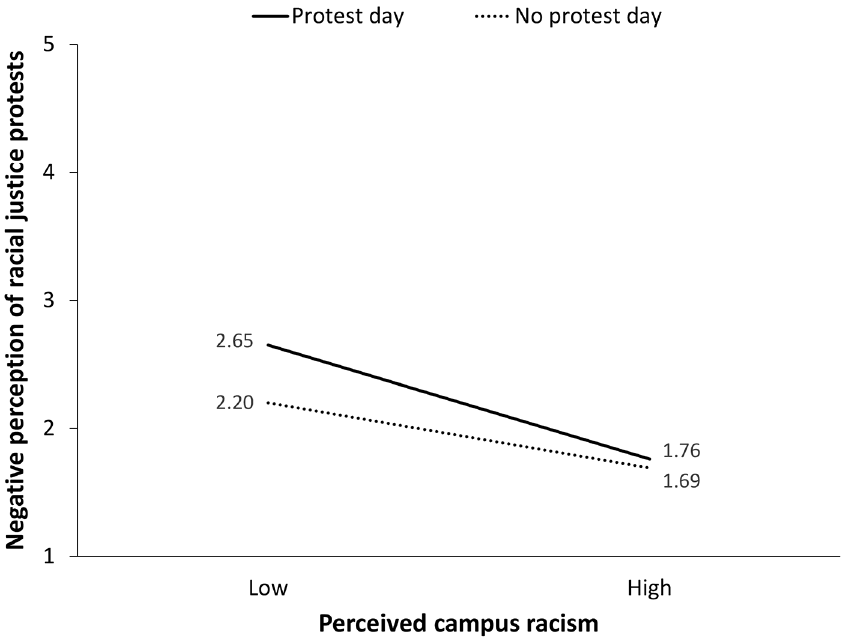
Figure 2. Negative perception of racial justice protests as a function of the interaction between perceived campus racism and condition (protest vs. no-protest